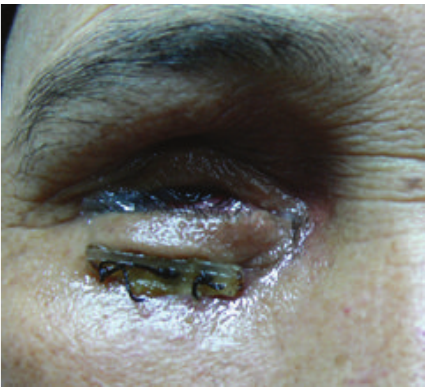
Figure 8: Deepening sutures tied over bolsters on the skin surface.